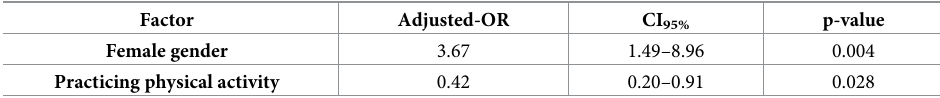
Table 5. Lifestyle choices associated with mental health in medical students: Multivariate